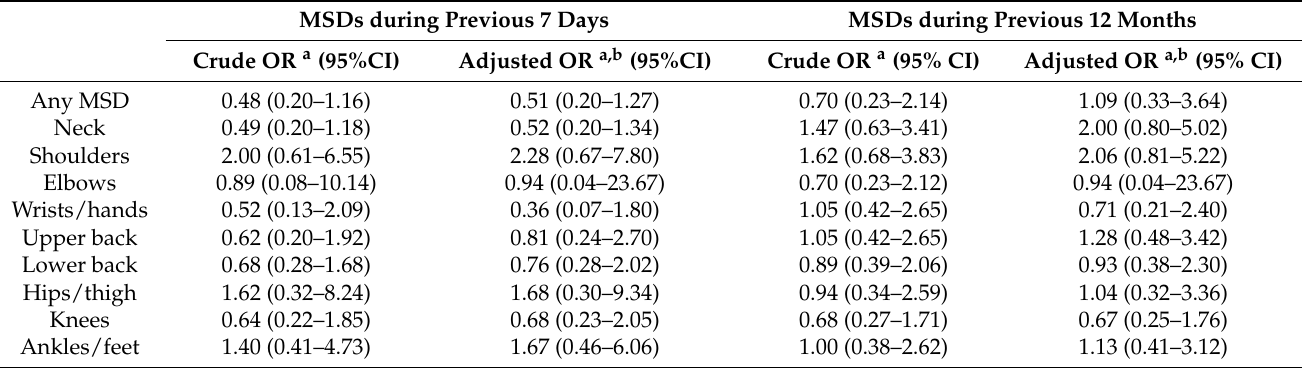
Table 3. Association of MSDs during the previous 7 days and the previous 12 months with physical activity practice.